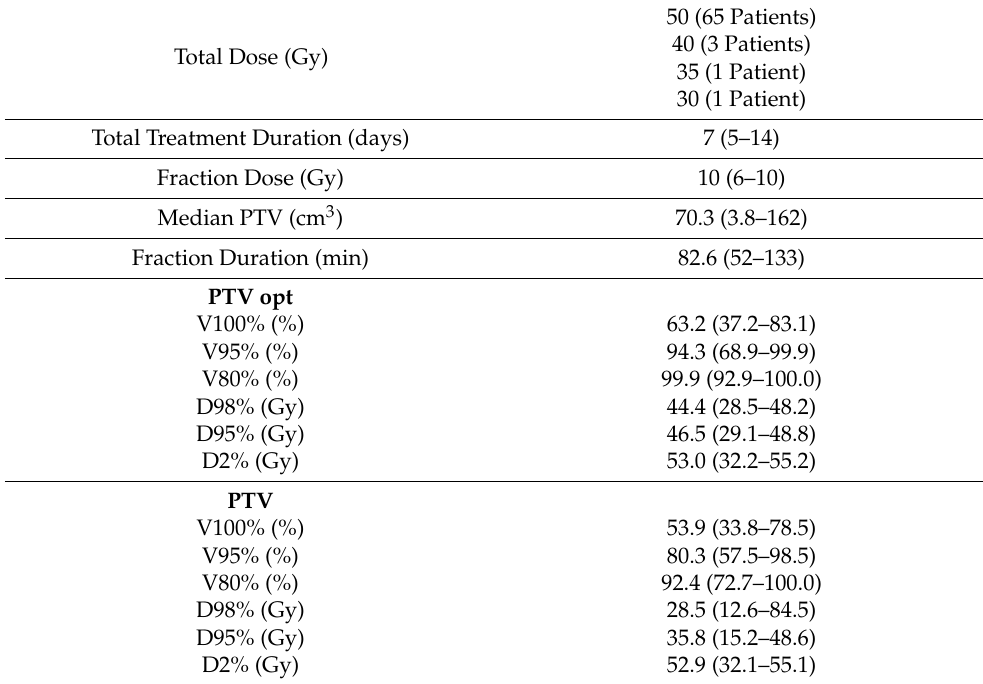
Table 2. Median (min-max) dosimetric data for initial